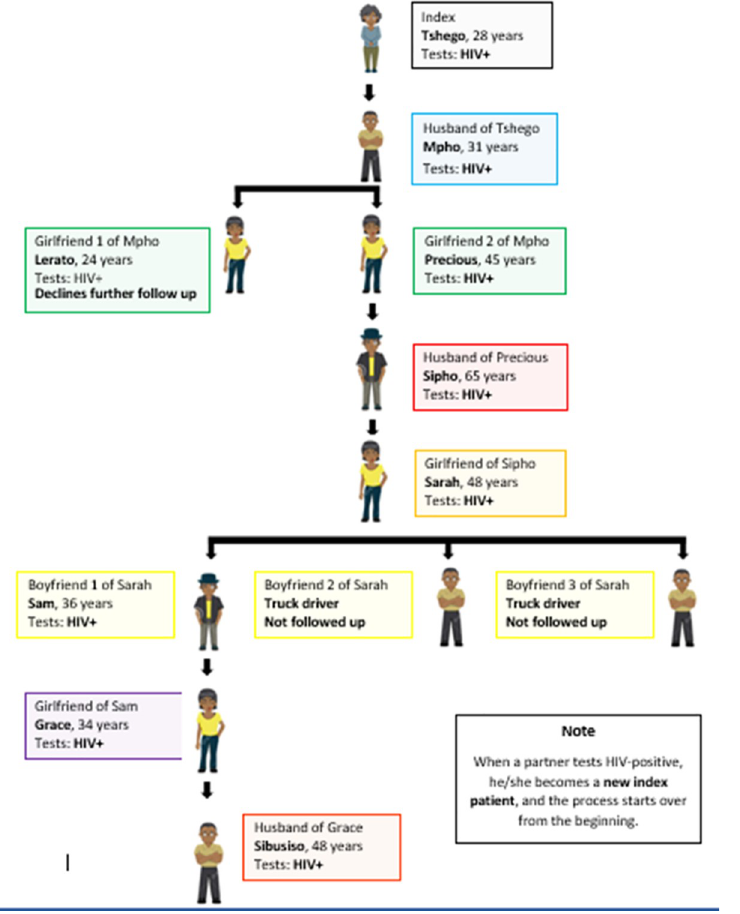
Fig 1. Diagrammatic sexual network mapping used to train index